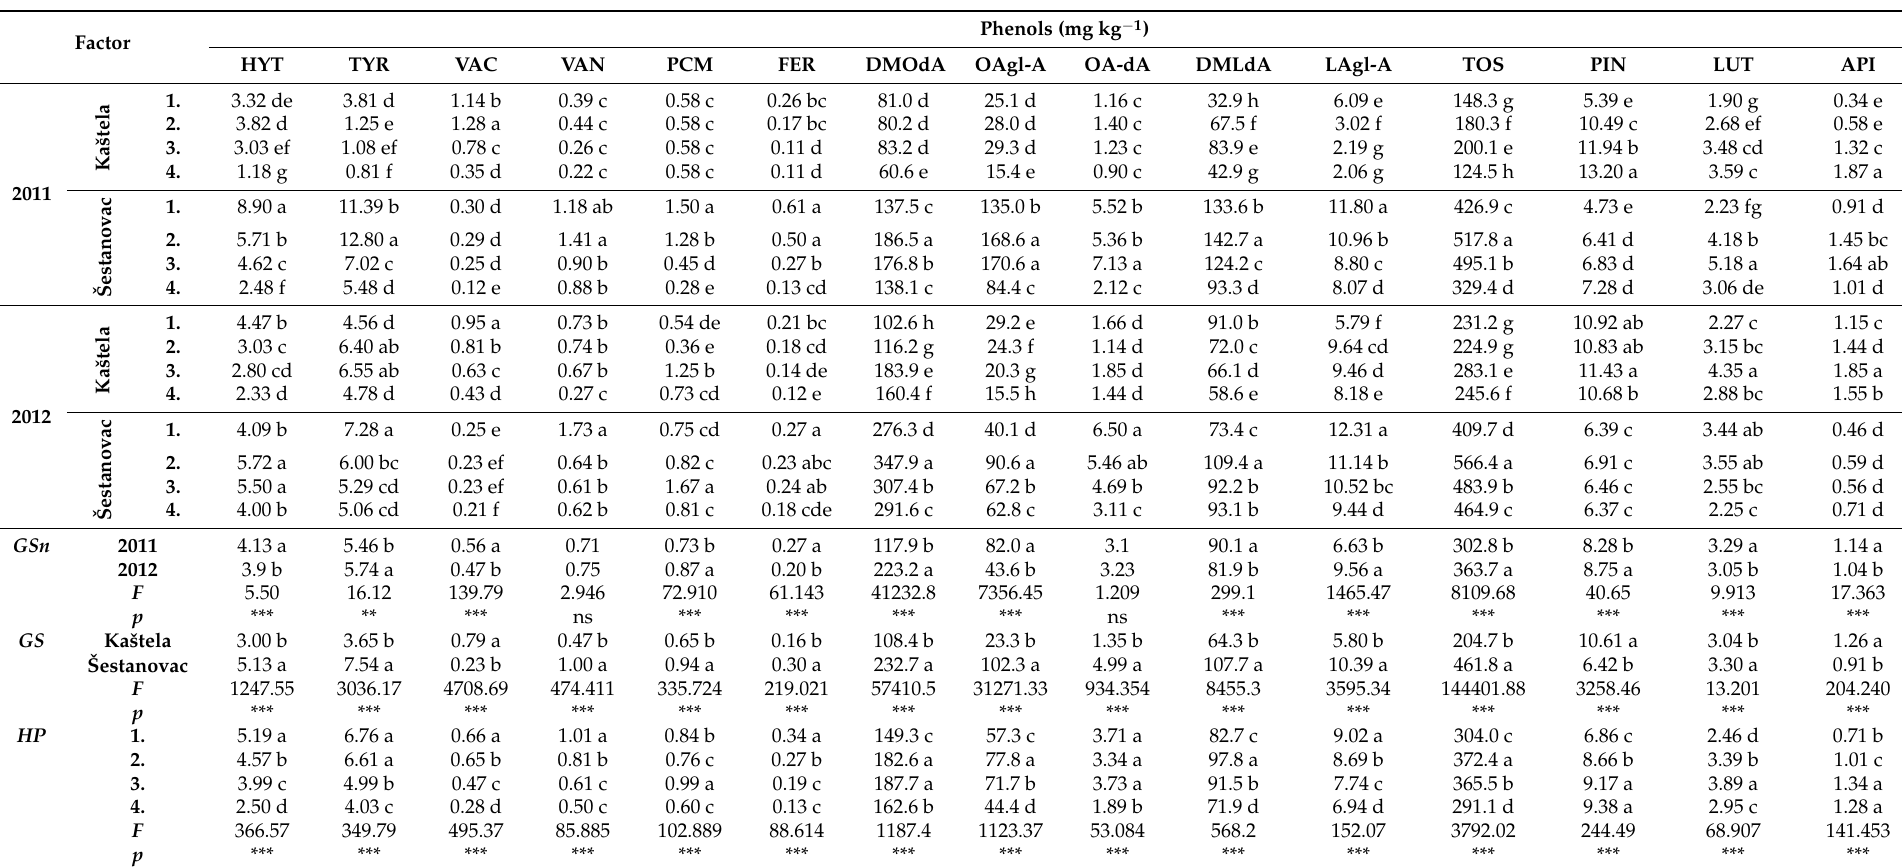
Table 2. Phenolic profile of Leccino virgin olive oils during ripening obtained from two distinct olive orchards (Kaštela and Šestanovac) in two successive growing